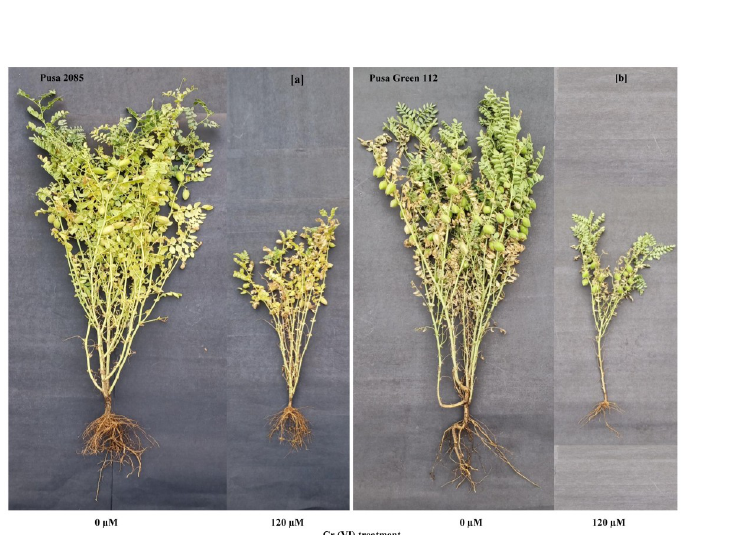
Fig 13. Effects of the chromium (Cr) treatments (control and 120 μ M) on plant growth, above-ground biomass, and plant productivity in two chickpea varieties grown in pots. (a) Pusa 2085. (b) Pusa Green 112.